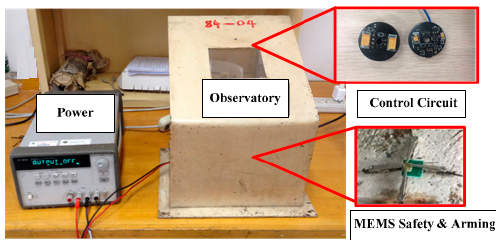
Figure 13. Test platform used to test the den energy-absorbing materials.